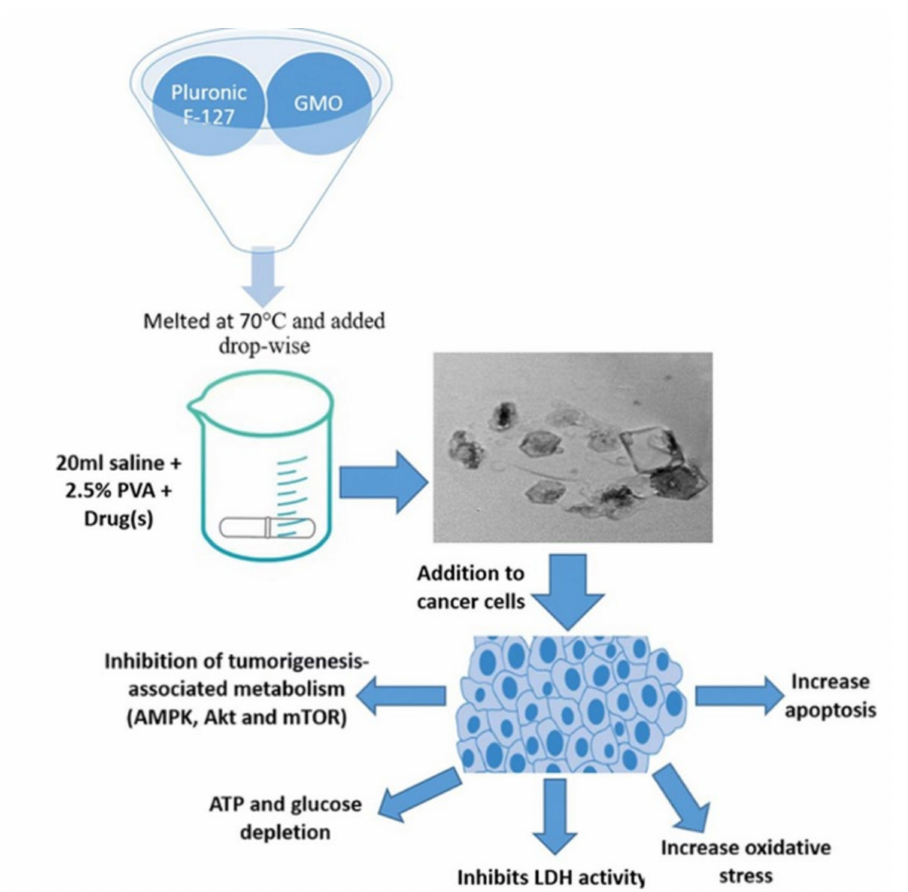
Figure 4. The emulsification process is used to manufacture cisplatin and cisplatin–metformin nanocubosomes. When CRC cells are treated with drug-loaded nanocubosomes, multiple metabolic pathways, including the AMPK/mTOR and Akt/mTOR pathways, are significantly inhibited. As a consequence of the depletion of ATP and glucose, there is a rise in oxidative stress and apoptosis. Another way the nano-cubosomes cause cytotoxicity is by inhibiting LDH activity, which leads to caspase-3 activation. Source: Reproduced from